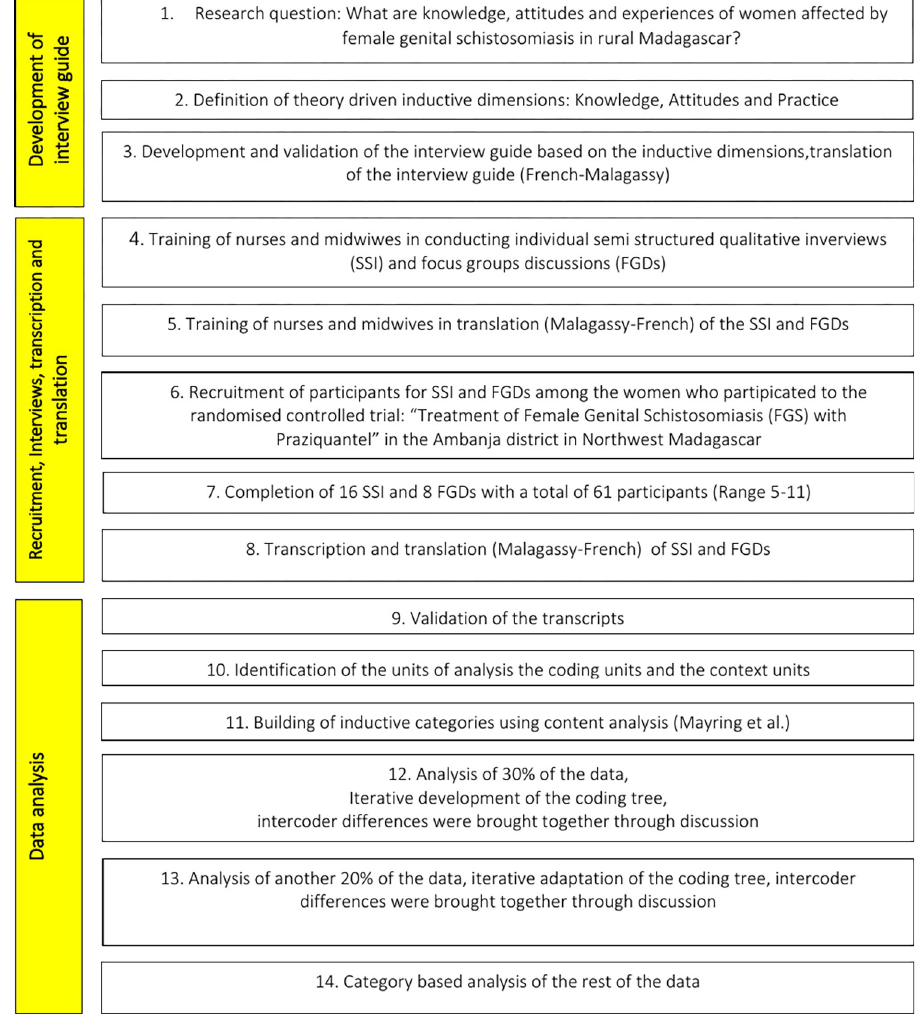
Fig 2. Flow chart of the methodological approach.